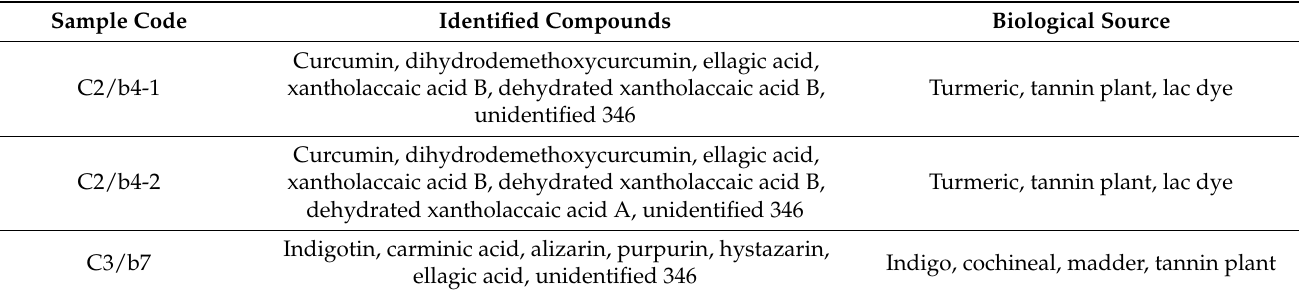
Table 3. Summary of identified colourants, possible dyestuffs sources and type of